Question: State the chart type depicted above.
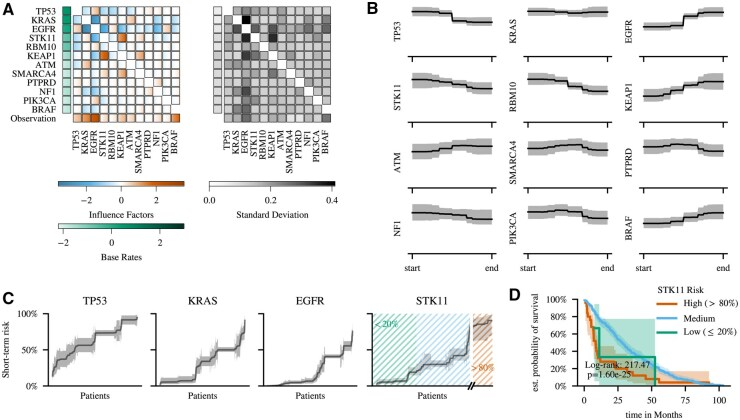
Answer: survival